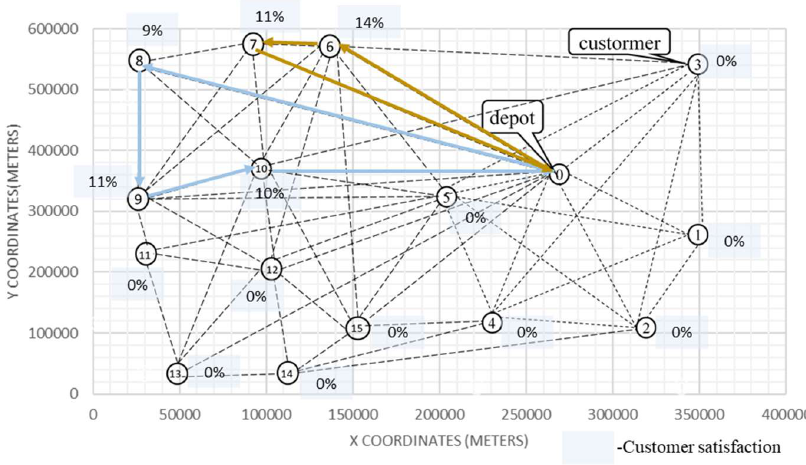
Figure 18. Obtained flight-mission plan for the first FTW.